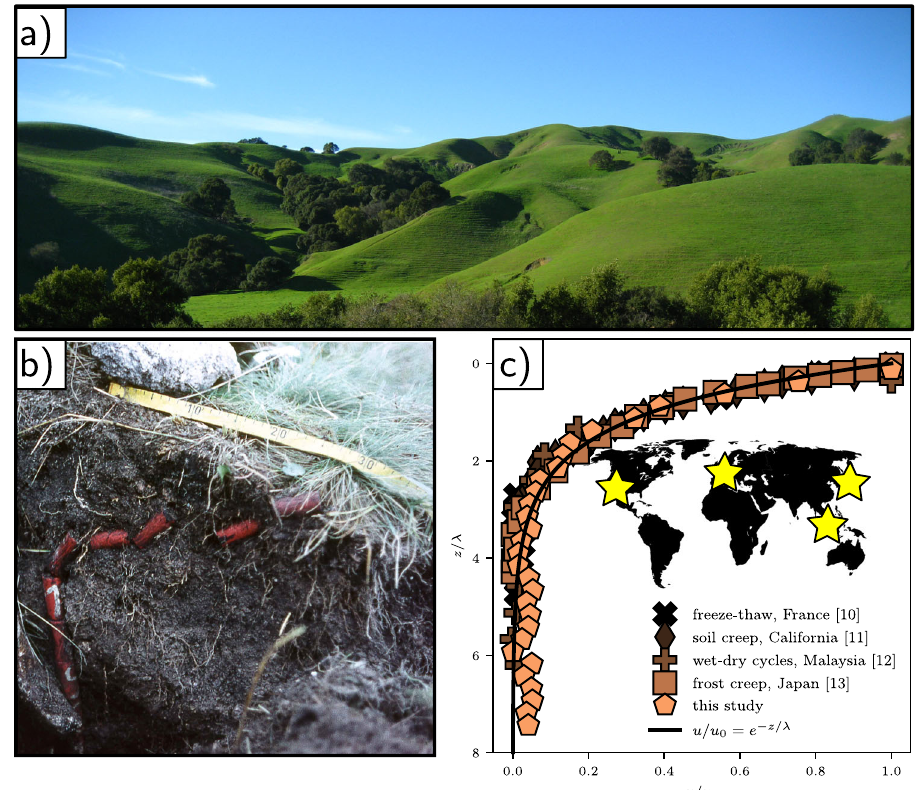
Fig. 1 Soil creep observations and scales. a Canonical soil-mantled hillslopes, Briones Regional Park, California. b Excavated Young Pit indicating the displacement of tracer pegs over a 17-year interval in the Sudetes Mountains, Poland (image: Alfred Jahn). c Compilation of soil deformation data from four studies and fi eld environments, originally compiled by Roering 21 : freeze – thaw cycles near Strasbourg, France 10 ; wet – dry cycles in Stanford, California 11 ; wet – dry cycles in Kuala Lumpur, Malaysia 12 , and freeze – thaw cycles in the Japanese Alps 13 . Data are collapsed by a normalized exponential